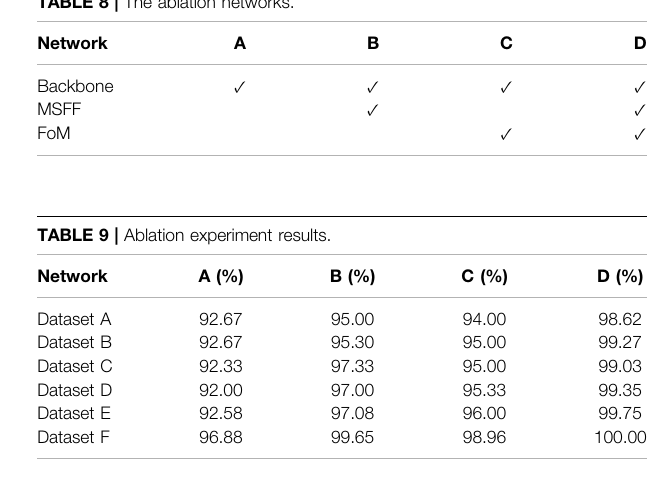
TABLE 8 | The ablation networks.